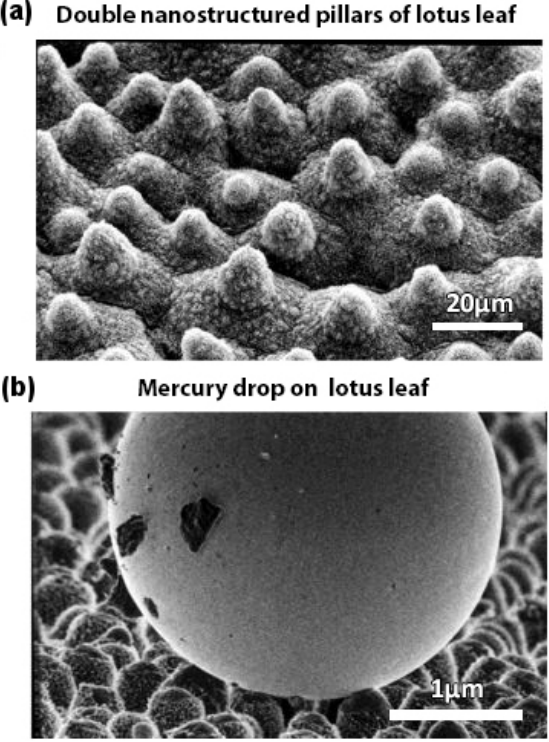
Figure 2. Lotus effect. Scanning electron microscopy (SEM) images of ( a ) double nanostructured pillars on the surface of a lotus leaf and ( b ) composite mercury drop on top of the rough surface of a lotus leaf making a large contact angle. Adapted with permission from [20]. Copyright 2004, American Chemical Society.